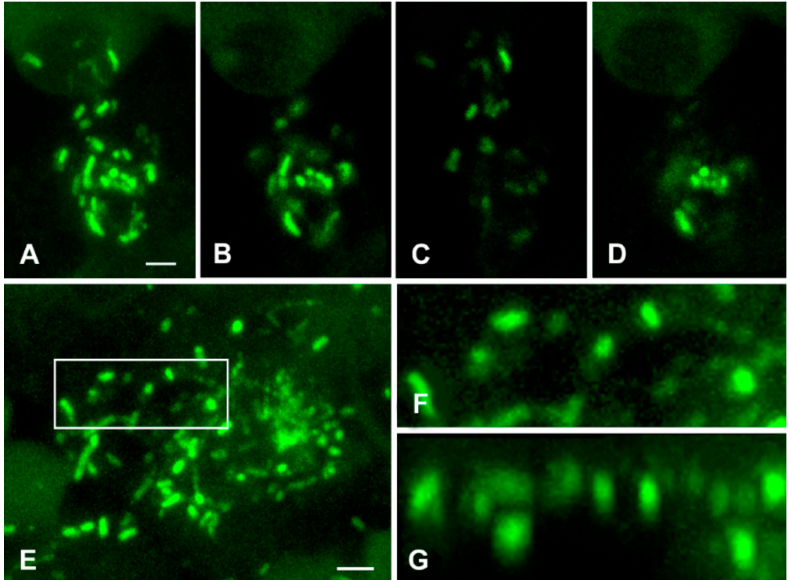
Figure 8. Immunolabelling of M. tuberculosis in the perifocal region of lung tissue. ( A ) The maximum intensity projection of the aggregate of bacteria (20 µ m-thick optical sections). ( B – D ) 2 µ m-thick optical sections through di ff erent parts of this aggregate. ( E ) The aggregate with rounded and elongated, but not rod-shaped, structures. ( F ) High magnification of rounded structures in the region defined in ( E ) (rectangle). ( G ) Side view of the same region (XZ projection after blind deconvolution) shows that the structures are really rounded. Scale bar = 2 µ